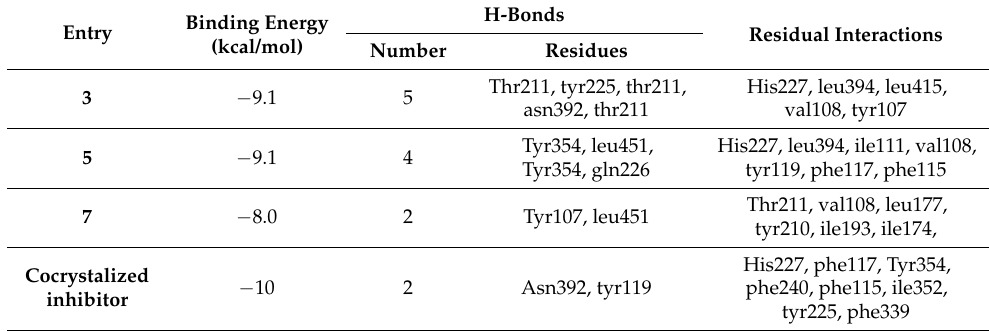
Table 3. Docking results of new compounds with N-myristoyl transferase